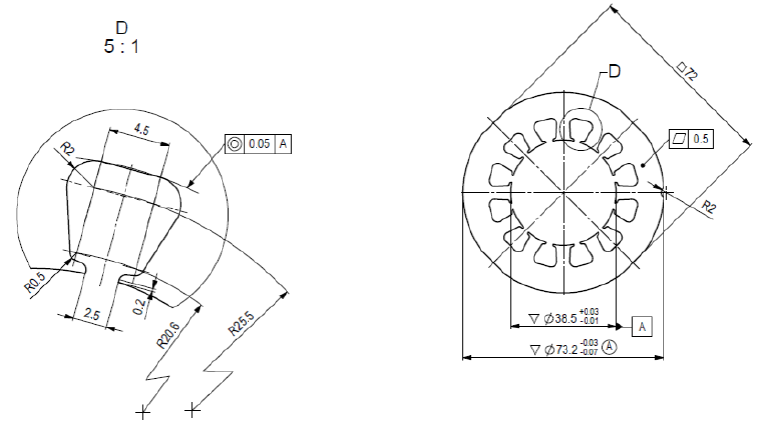
Figure 7. Dimensions of the stator stack.